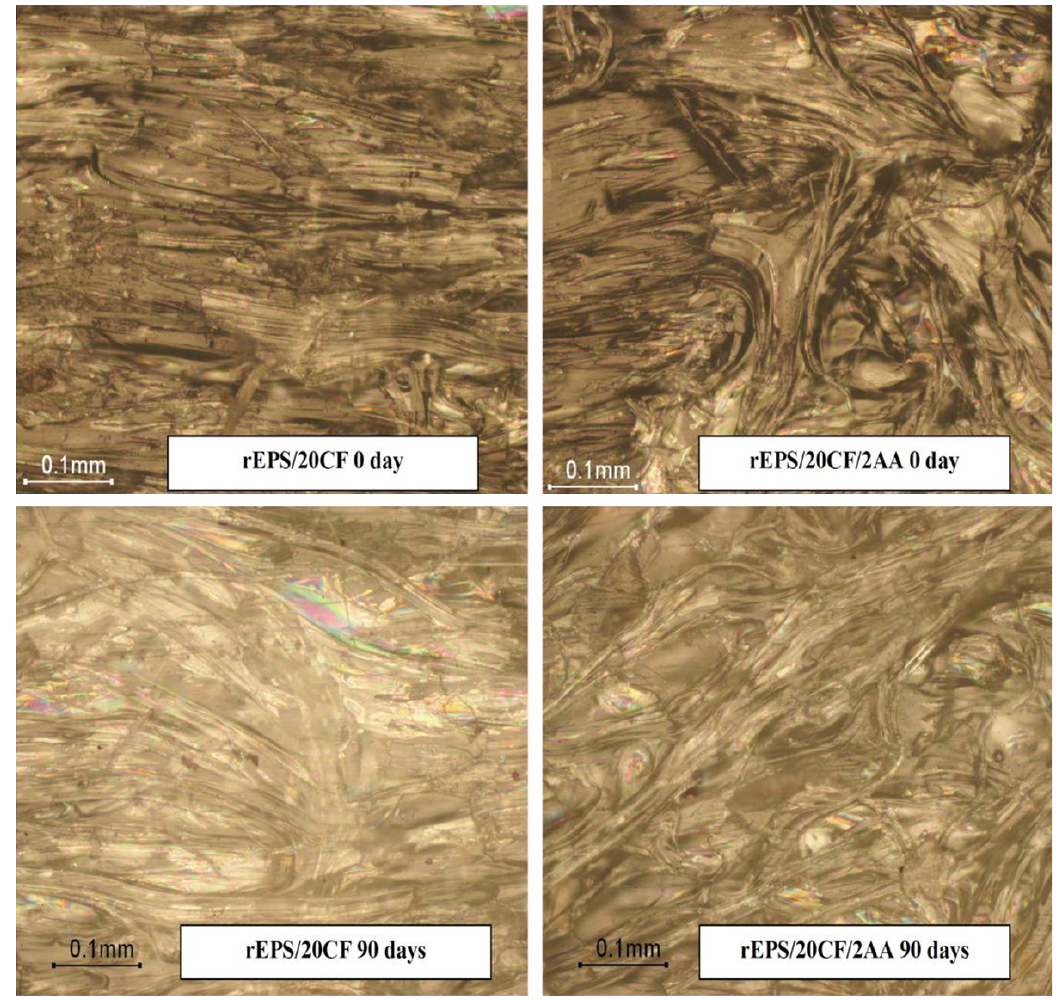
Figure 4. Dptical micrographs of the surfaces of the composites before and after 90 days of exposure in the simulated soil.